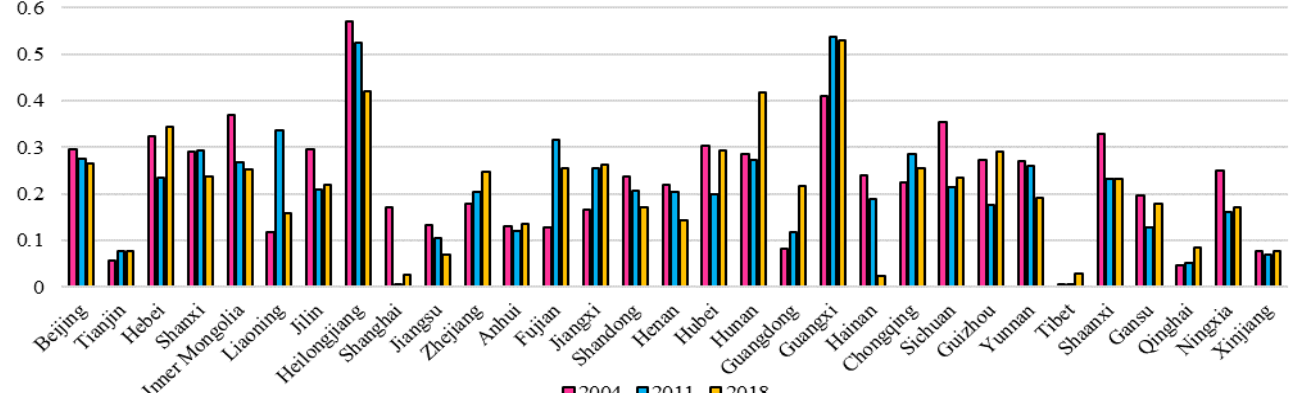
Figure 4. Response index of forest ecological security.